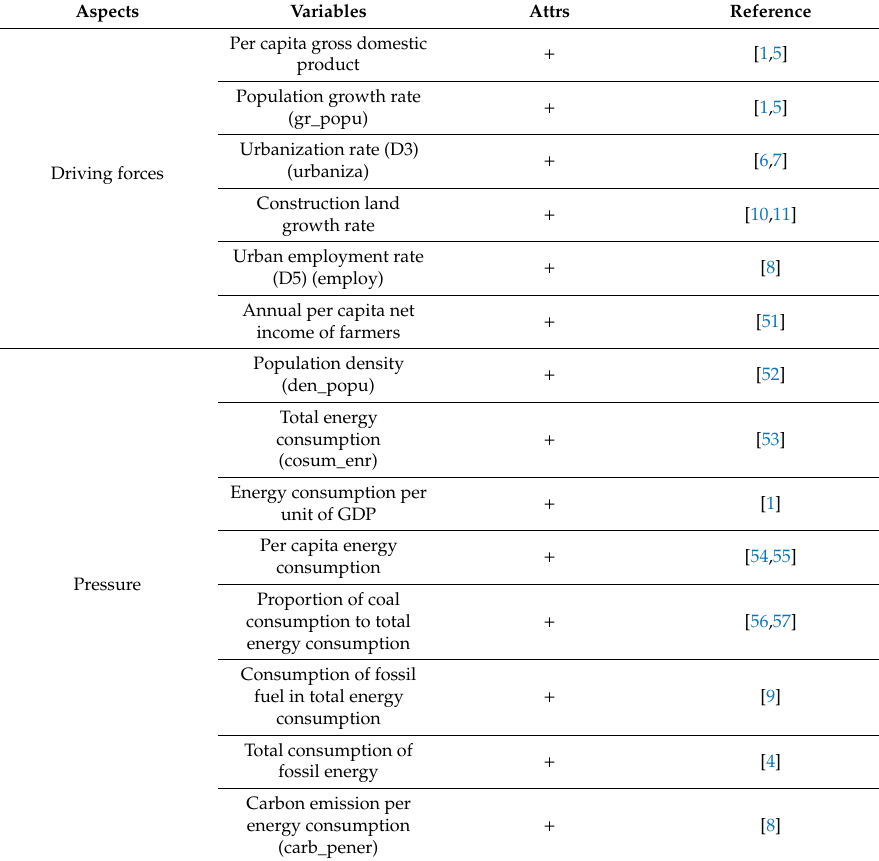
Table 3. Descriptions on eco-e ffi ciency influential